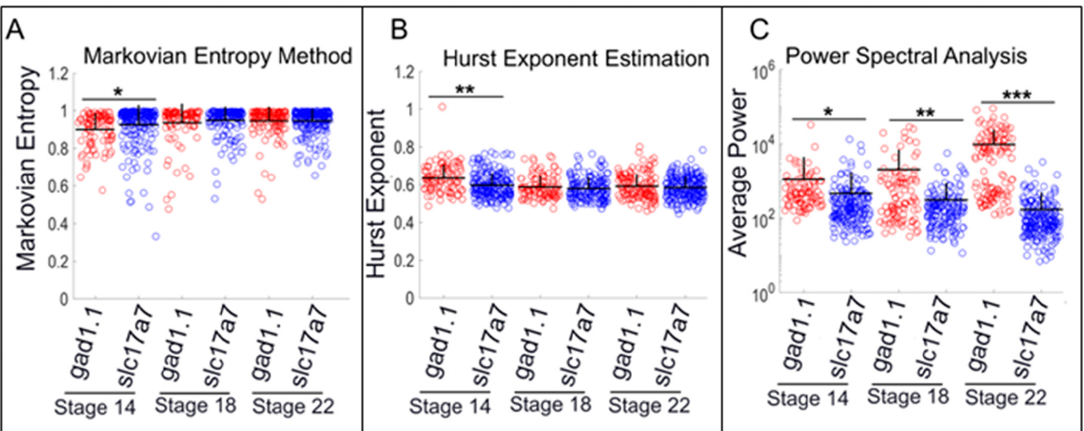
Figure 3. Presumptive glutamatergic cells dissociated at neural plate stage show more chaotic activity, while presumptive GABAergic cells display more periodic calcium dynamics. Comparison of Markovian entropy, estimated Hurst exponent, and average power between inhibitory ( gad1.1 ) versus excitatory ( slc17a7 ) neurons at: ( A ) neural plate stage (Stage 14); ( B ) neural tube stage (Stage 18); and ( C ) early tailbud stage (Stage 22). Stars represent statistically significant di ff erences according to both Bonferroni-corrected two-sample Kolmogorov–Smirnov Test ( p < 0.05) and Cohen’s d statistics for e ff ect size (mean + SD; n = 5 cultures; * 0.2 ≤ | d | < 0.5, ** 0.5 ≤ | d | < 0.8, *** | d | ≥ 0.8). Markovian entropy was calculated with n = 4 and k = 1.